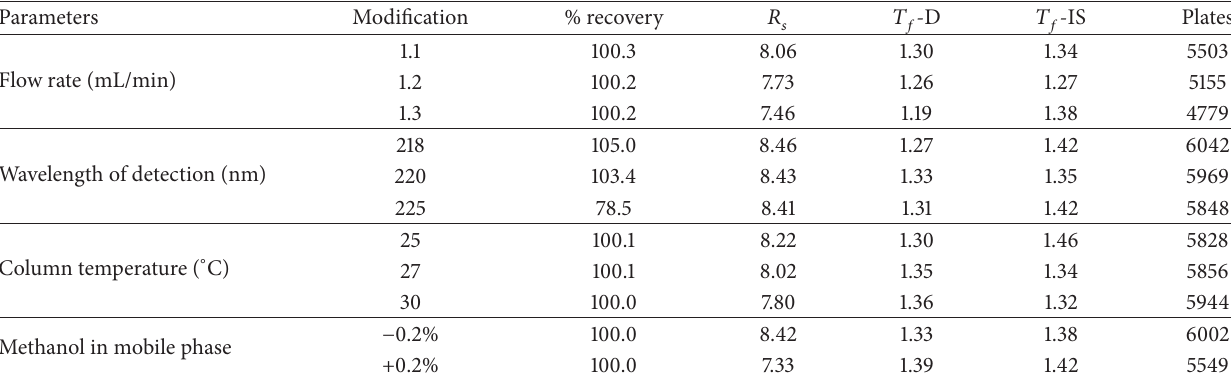
Table 1: Robustness.